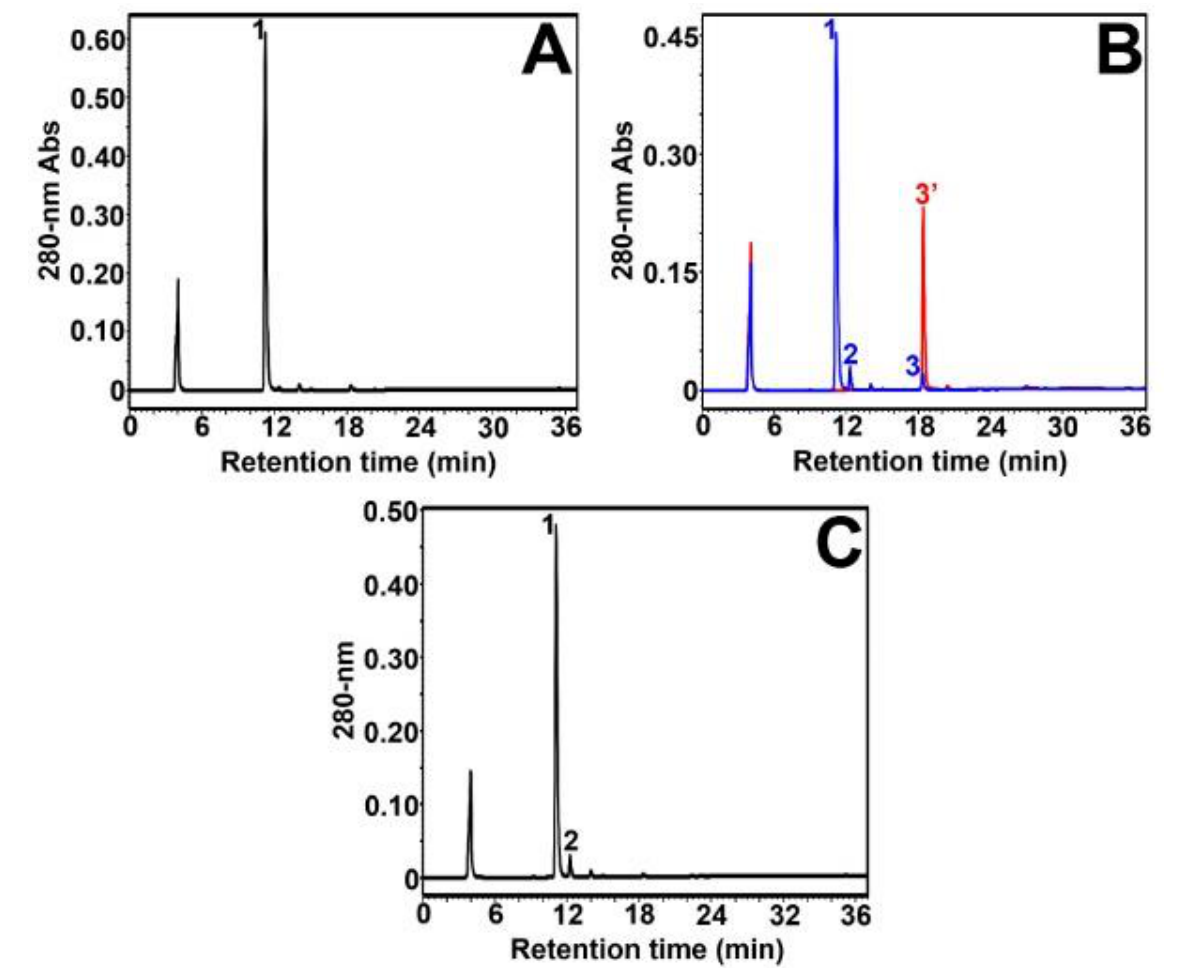
Figure 3. Reverse-phase HPLC analysis of VvANS product of (+)-DHM. ( A ) HPLC analysis of the commercial standard of 100 µM (+)-DHK in the reaction mixture containing no enzyme. ( B ) HPLC overlay chromatogram of the enzymatic degradation product of (+)-DHM (in blue) and the com- mercial standard of 100 µM myricetin (in red). ( C ) HPLC analysis of the non-enzymatic degrada- tion of 100 µM (+)-DHM in the reaction mixture containing iron(II) salt but no enzyme. The minor peak observed at about 4 min corresponds to ascorbate.